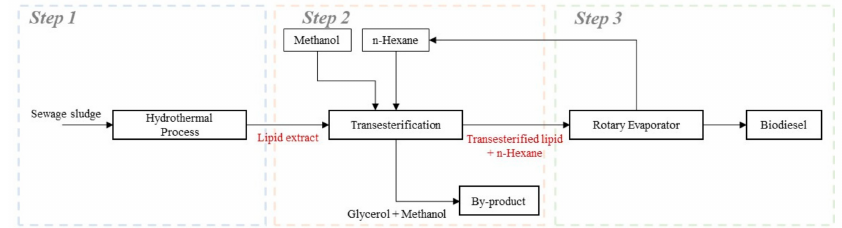
Figure 2. Schematics of the transesterification process coupled with hydrothermal lipid